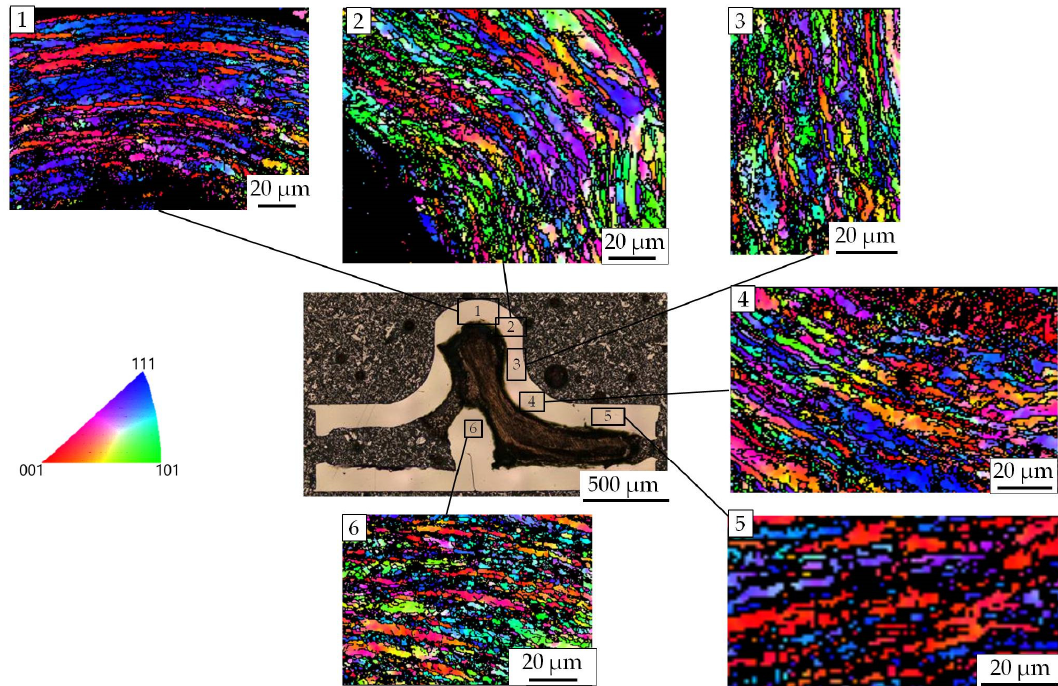
Figure 28. Microstructure in the initial microtube (C1220).